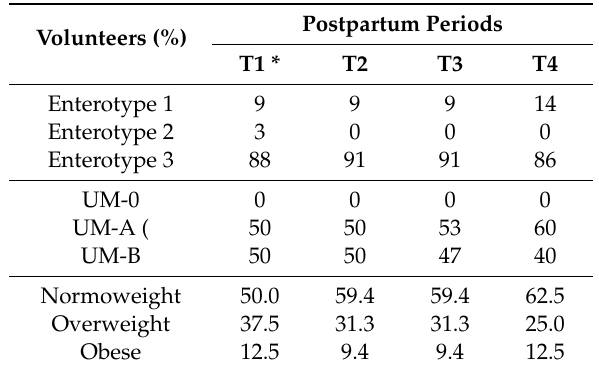
Table 1. Evolution of urolithin metabotypes (UMs) and enterotypes distribution in women ( n = 32) for one year after